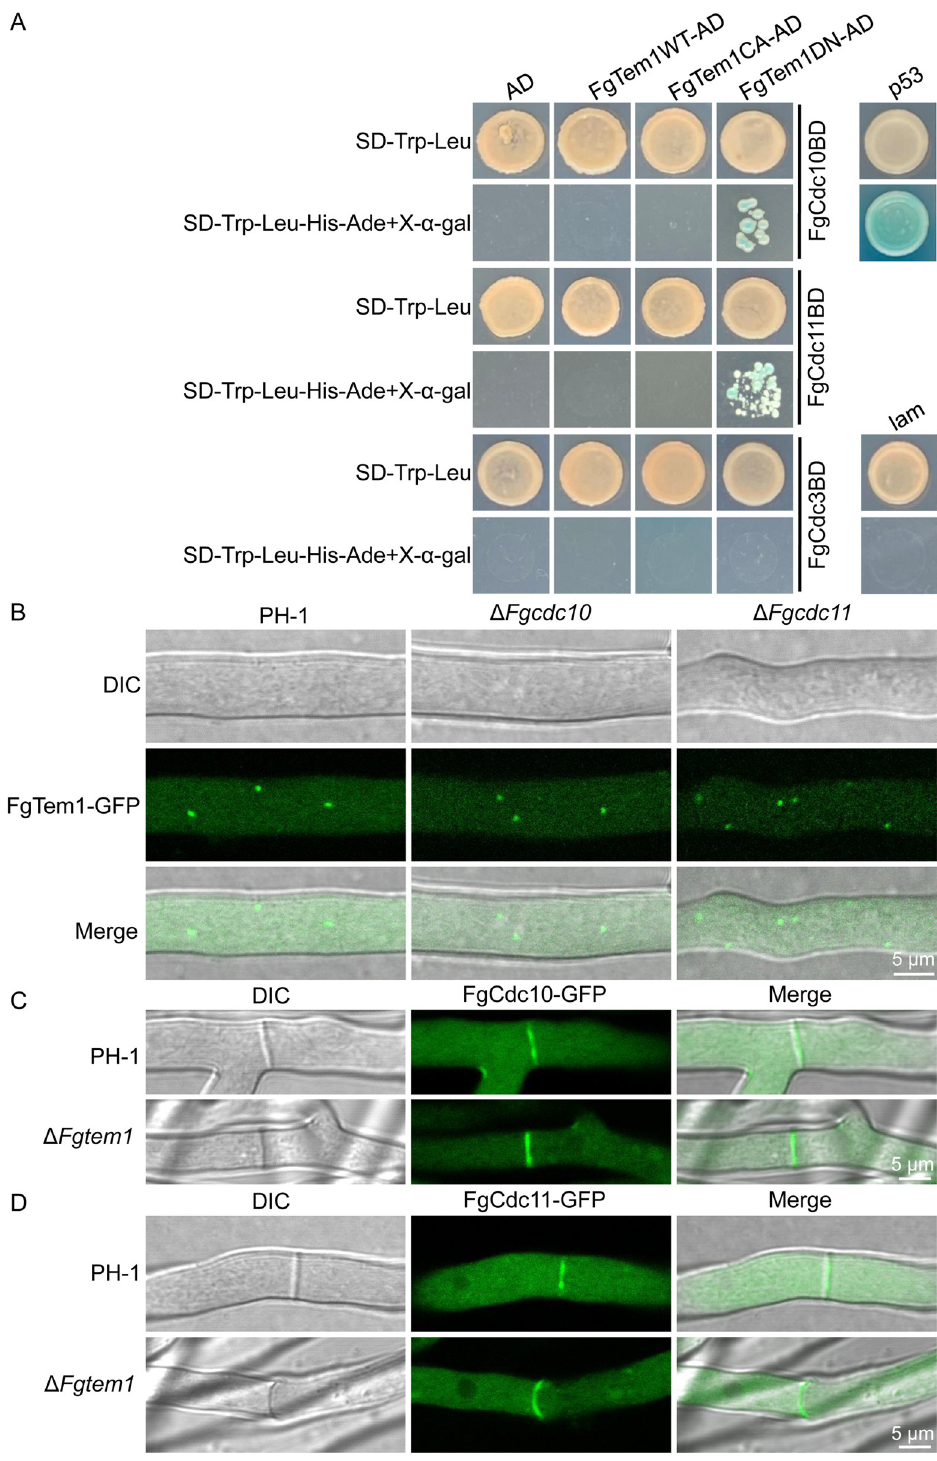
Fig 3. The relationship of FgTem1 with septins in F. graminearum . (A) Yeast two-hybrid assay showing the interaction of FgTem1 (FgTem1WT, FgTem1CA and FgTem1DN) with septins (FgCdc3, FgCdc10 and FgCdc11). The prey and bait constructs were assayed for growth on SD-Trp-Leu and SD-Trp-Leu-His-Ade+X- α -gal plates. p53 (pGADT7-T and pGBKT7-p53) and lam (pGADT7-T and pGBKT7-lam) were used as positive and negative controls, respectively. AD (pGADT7) and FgCdc3-BD, FgCdc10-BD, FgCdc11-BD were used as self-activated controls.